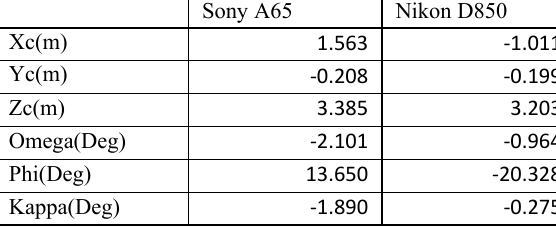
Table 2. Exterior orientation parameters